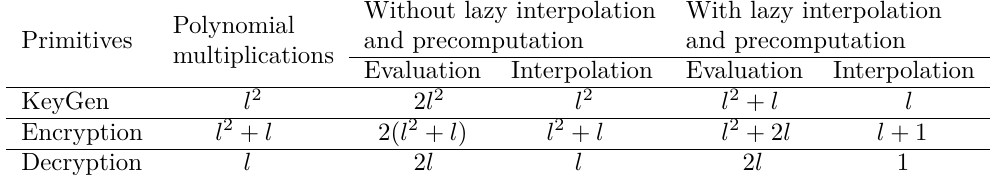
Table 1: Comparing number of evaluations and interpolations for different Saber primitives with and without lazy interpolation and evaluation. The number of 16 × 16 polynomial multiplications remain the same for both